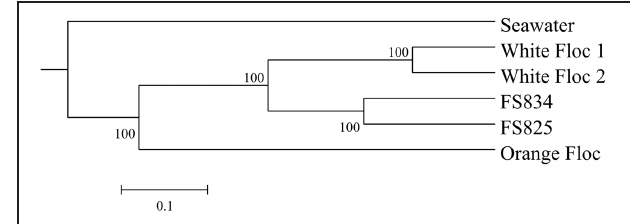
FIGURE 3 | UPGMA clustering tree of the bacterial community structure.